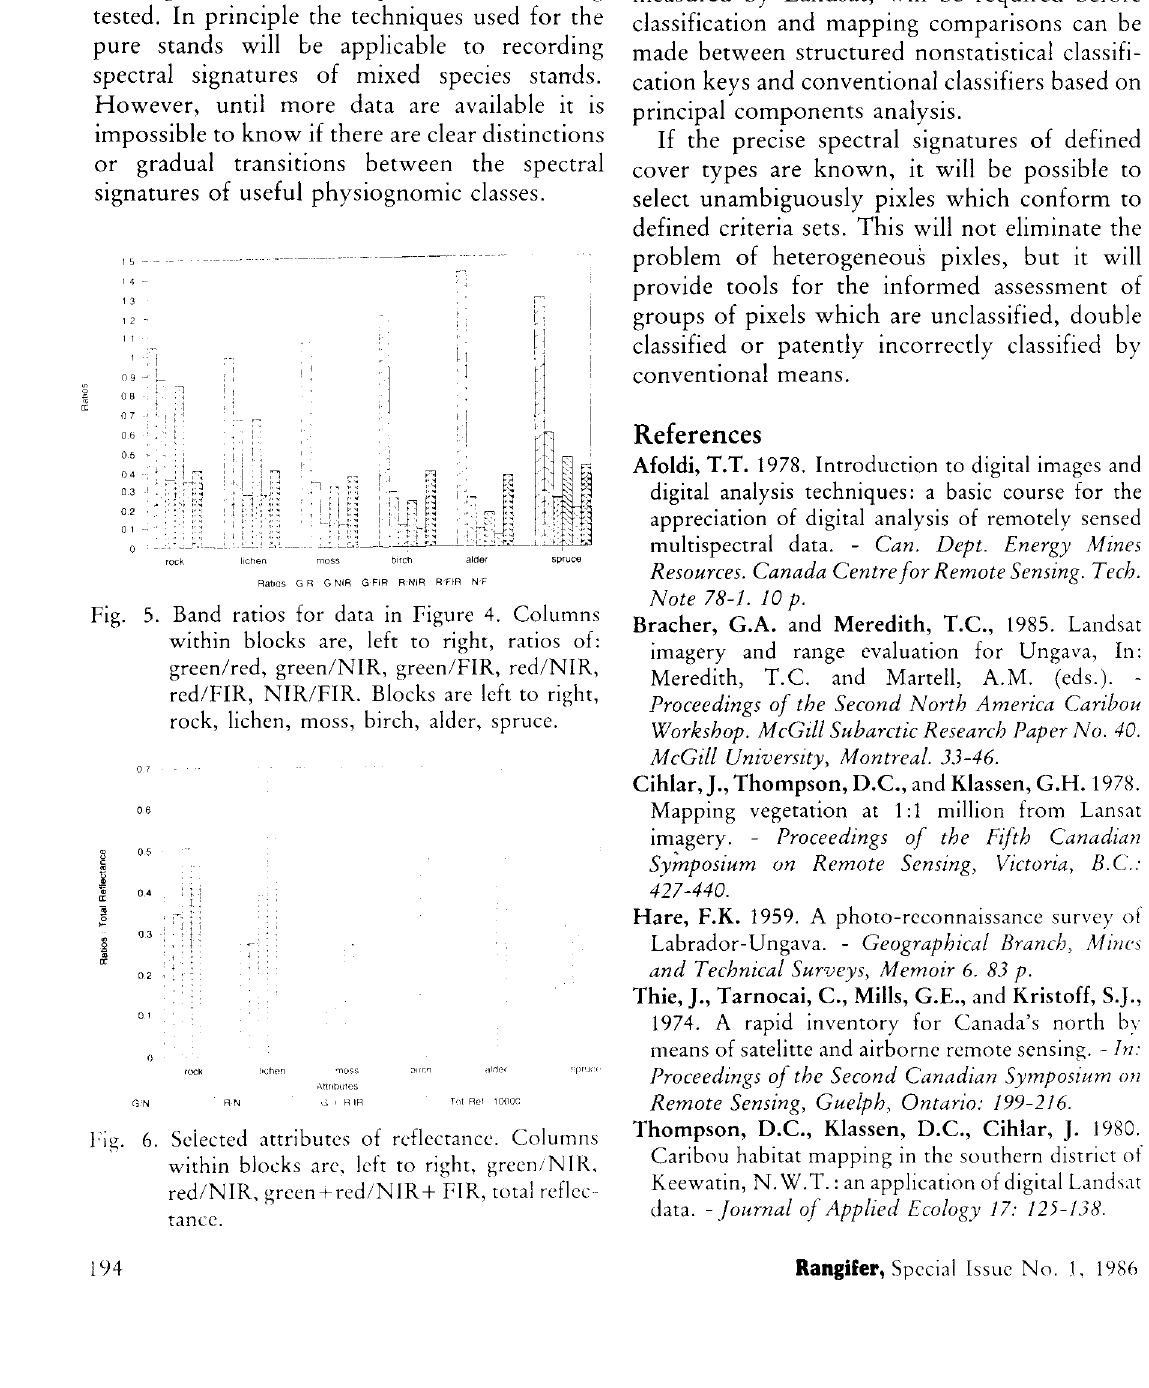
Fig. 5. Band ratios for data in Figure 4. Columns within blocks are, left to right, ratios of: green/red, green/NIR, green/FIR, red/NIR, red/FIR, N I R / F I R. Blocks are left to right, rock, lichen, moss, birch, alder, spruce.